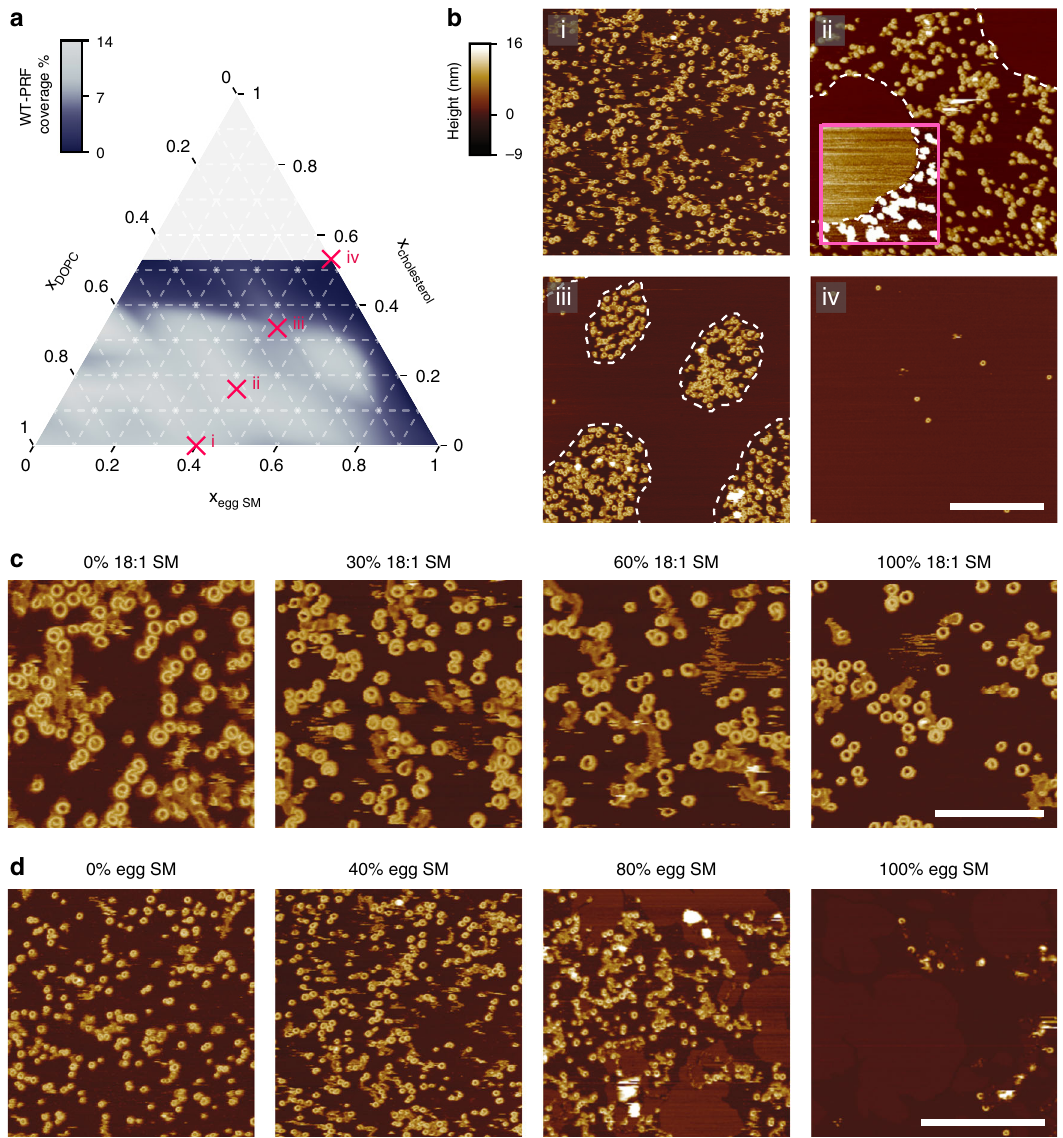
Fig. 3 Lipid order protects membranes from perforin pore formation. a Perforin coverage (as % of membrane surface, as assessed by AFM imaging) after incubation of supported DOPC/egg SM/cholesterol bilayers with 150 nM WT-PRF, as a function of the molar fractions ( x ) for the constituents of the bilayer (total = 1). See Supplementary Fig. 4 for explanation of the lipid phases observed in these membranes. Source data are provided as a Source Data fi le. b AFM images of perforin pores on supported lipid bilayers of the compositions i – iv labelled in a . AFM samples were incubated and imaged at 37 °C. For the area marked by a pink square in the top right image, the colour scale has been saturated (4 nm instead of 25 nm full range) to more clearly identify the enhanced thickness (height) of a liquid-ordered domain and the absence of perforin pores (white at this scale) on such domains. Throughout the images, lipid-phase boundaries are marked by dashed lines. Scale bar, 500 nm. c Representative AFM scans of supported DOPC bilayers, doped with different relative amounts of 18:1 SM (0 – 100%), and incubated with 150 nM WT-PRF. The doping with this disorder-prone SM variant does not appear to affect perforin pore formation, showing a similar coverage across all samples. This demonstrates that the observed perforin inhibition on egg SM membranes in a and b is not due to the SM headgroup (identical for egg SM and 18:1 SM), but due to the SM-induced changes in membrane order; unlike egg SM, pure 18:1 SM is in a liquid disordered state at 37 °C, just like DOPC 24 . Colour scale as in b . Scale bar, 200 nm. d As c , for comparison, except that the DOPC bilayer was doped with egg SM (0 – 100%). Phase separation is visible at 80%, and perforin coverage is notably diminished at 100% egg SM. These images were extracted from the dataset used to compose the plot shown in a . Note the different length scale. Colour scale as in b . Scale bar, 500 nm. All samples were incubated and imaged at 37